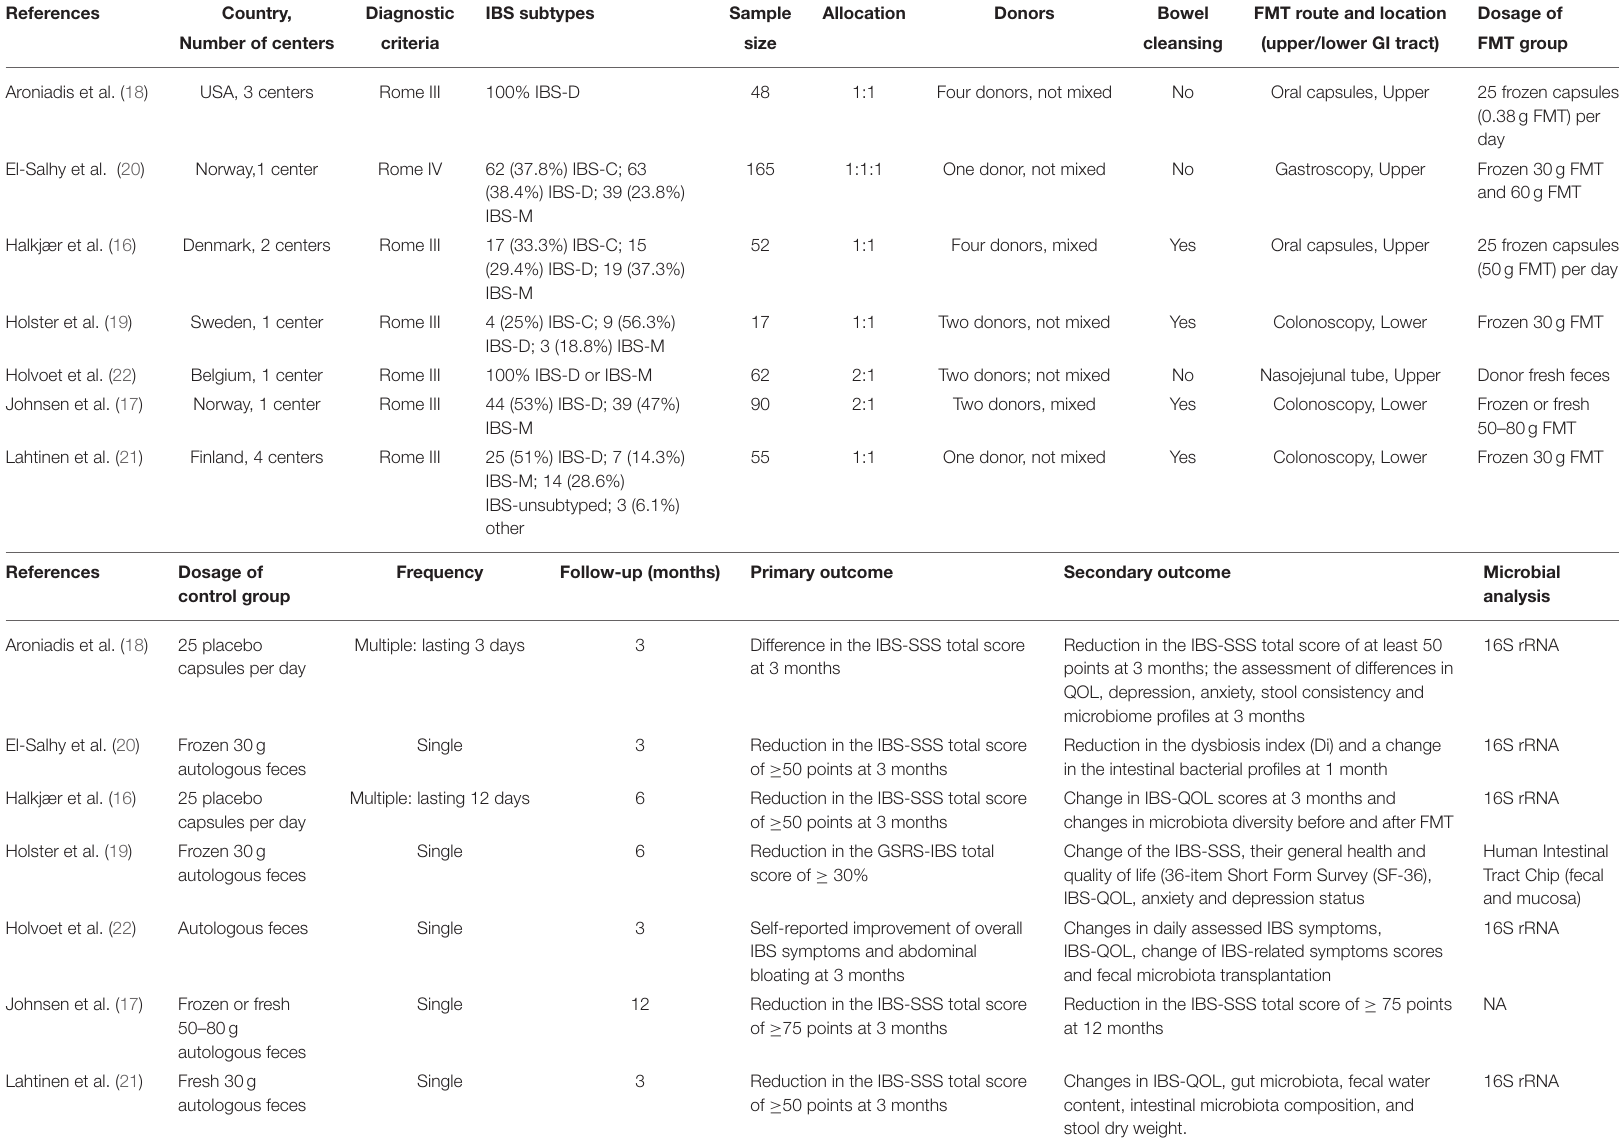
TABLE 1 | General information of included seven